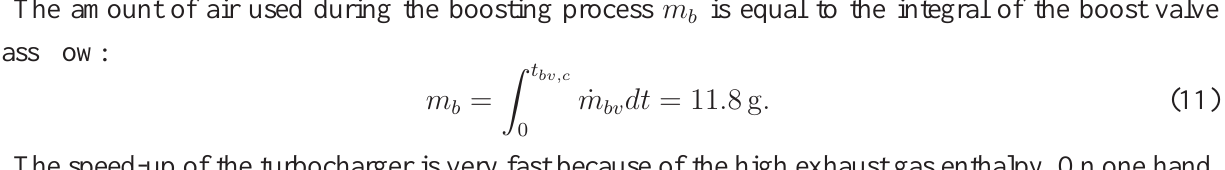
Figure 4. Trajectory of the compressor operating point in simulation during a load step with intake manifold boosting from 1.7 bar to 16.7 bar p time elapsed after the load